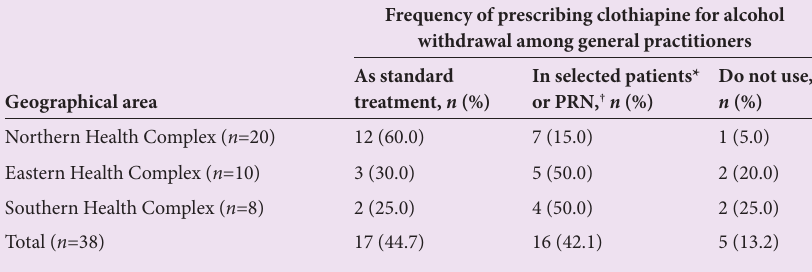
Table 3. Selection of clothiapine for substitution therapy among general practitioners in different geographical areas